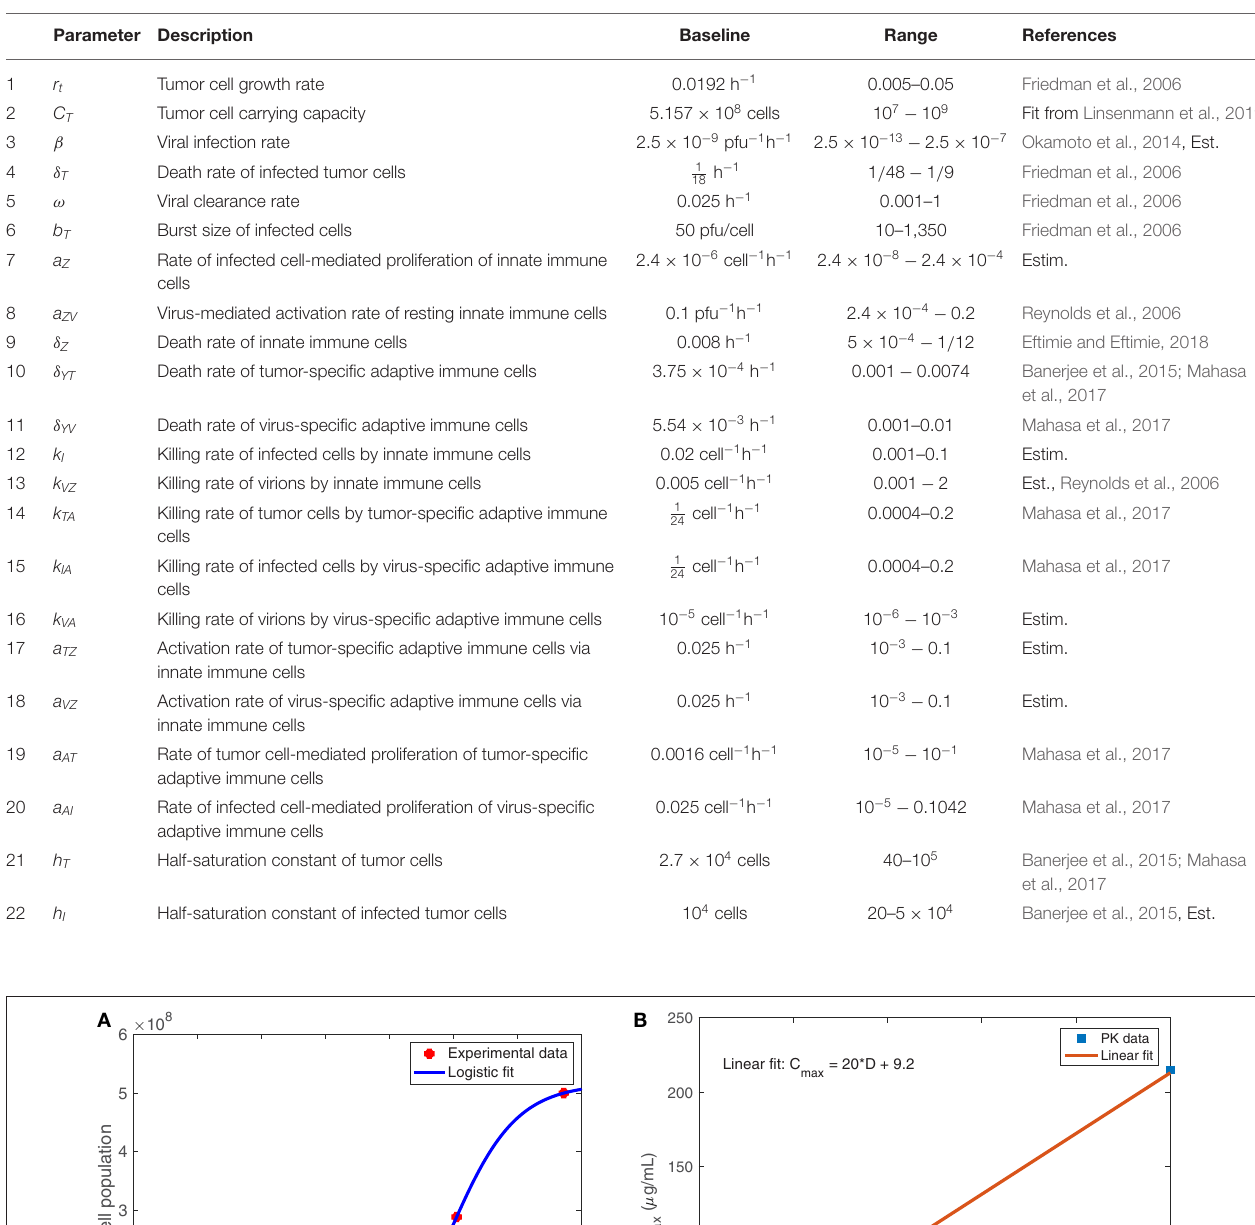
TABLE 2 | Model parameters.